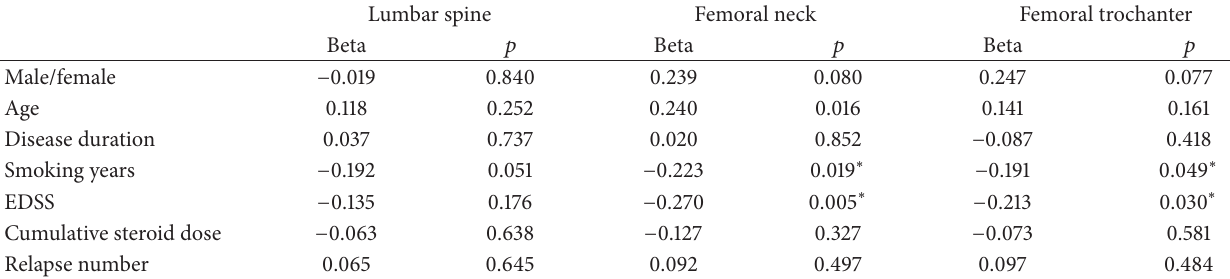
Table 3: Multiple regression analyses of